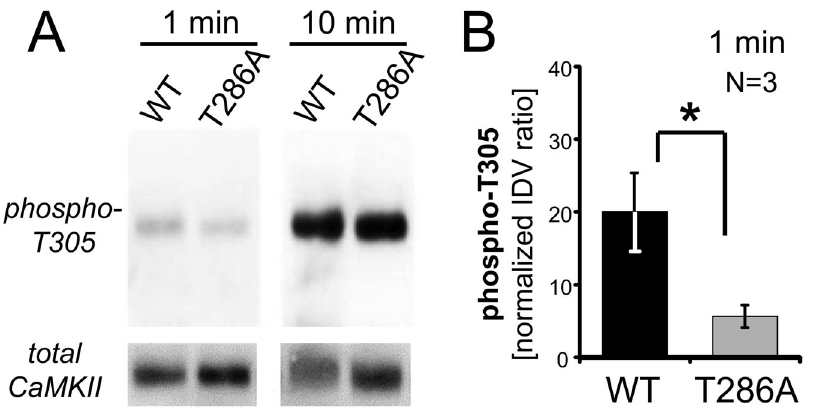
Figure 4. CaMKII T305 phosphorylation is further reduced for the T286A mutant. A , T305 phosphorylation was detected by Western analysis after reactions corresponding to the kinase activity assays shown in Fig. 1 (1 min at 30 u C, but without substrate peptide) or after extended reaction times (10 min). B , Quantification of the relative T305 phosphorylation by the ratio of the phospho-T305 and total CaMKII immuno-detection values (IDV) shows significantly lower phosphorylation of the T286A mutant in our 1 min kinase assay conditions (N=3 different extracts for each kinase form; *: p , 0.05 in two-tailed t-test). The IDV ratio for T286A was , 28% ( 6 7.6%) of wild type after the 1 min reactions; in the 10 min reaction experiment shown in panel A, this ratio was , 83%, consistent with the faster wild type reaction reaching saturation faster.